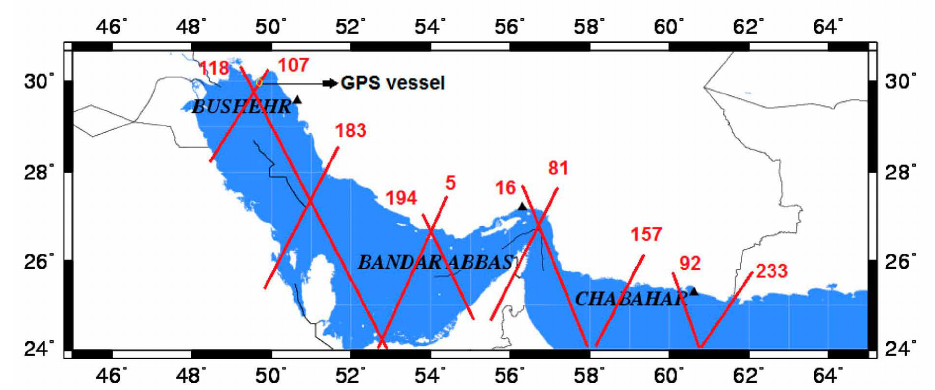
Fig. 2. Spatial distribution of study coastal tide gauges, within the Iranian tidal network, located at Bushehr, Bandar Abbas and Chabahar ports, GPS vessel deployment, and the altimetry ground